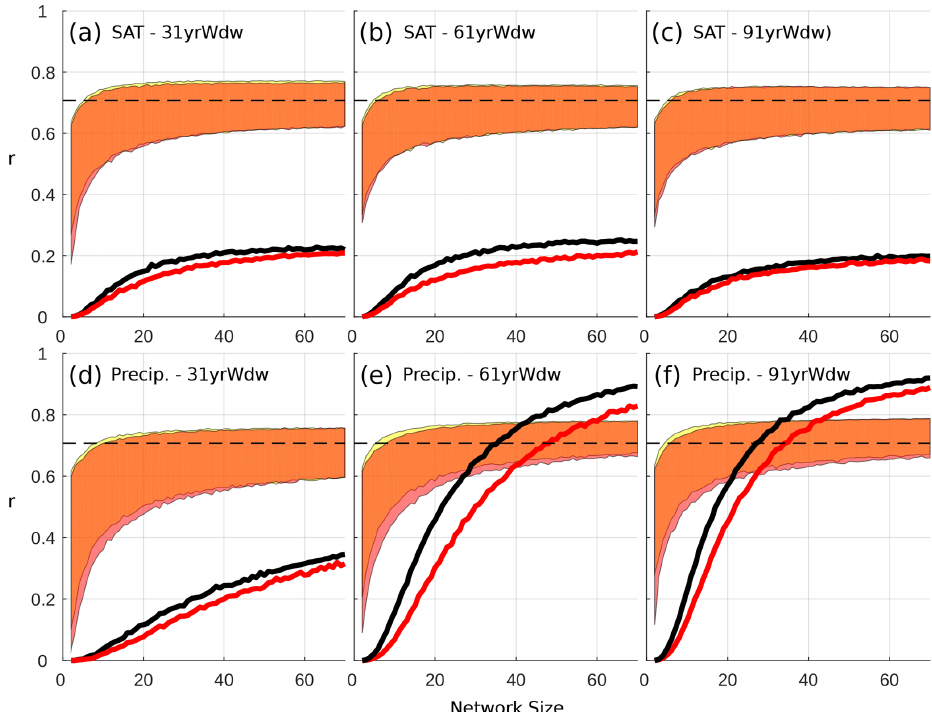
Figure 12. Differing reconstruction skill achieved when sourcing proxies from the entire Southern Hemisphere (yellow envelopes) and the entire Southern Hemisphere, excluding proxies whose teleconnections with SAM have a significant ( p < 0 . 05) correlation with ENSO (hatched regions in Figs. 9 and 11; red envelope). The correlation between a SAT-derived or precipitation-derived reconstruction and the SAM is plotted on the y axis, while the number of sites used ( n = 2 : 70) in a reconstruction is plotted on the x axis. Shaded regions represent the range between the minimum of the 5th percentile and the maximum of the 95th percentile for each network size across 10000 reconstructions (described in Sect. 2.3). The black lines indicate the percentage of SH reconstructions (yellow envelope) that meet or exceed our skill threshold of being able to explain 50% or more of the variability in the SAM. The red line indicates the same thing, but for those reconstructions that exclude ENSO-sensitive proxies (red envelope). The dashed black line indicates the r value required to meet our skill